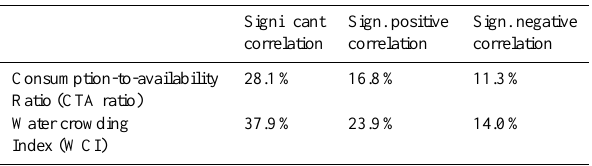
Table 3. Percentage of the global land area for which water scarcity conditions show a significant (positive/negative) correlation with ENSO-driven climate variability (as assessed with the JMA SST anomaly index). Water scarcity conditions were assessed by means of the CTA ratio for water stress and WCI ratio for water